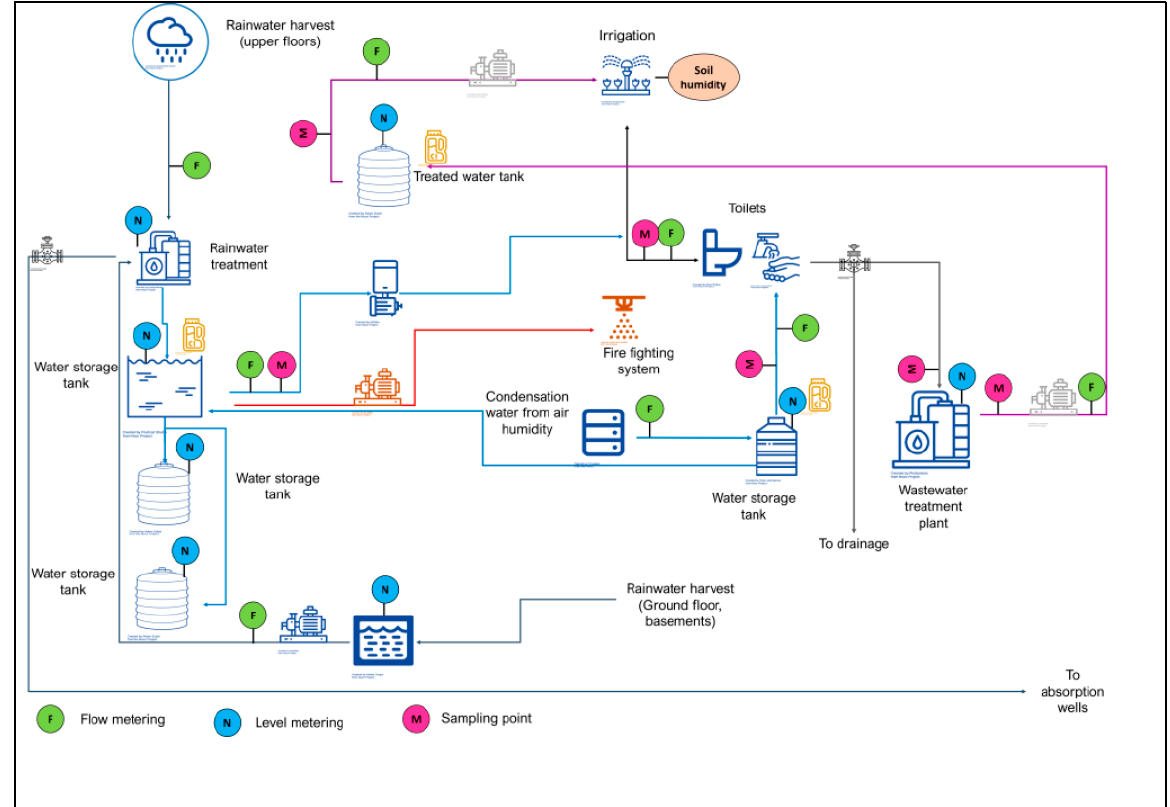
Figure 5. Water system flow chart.